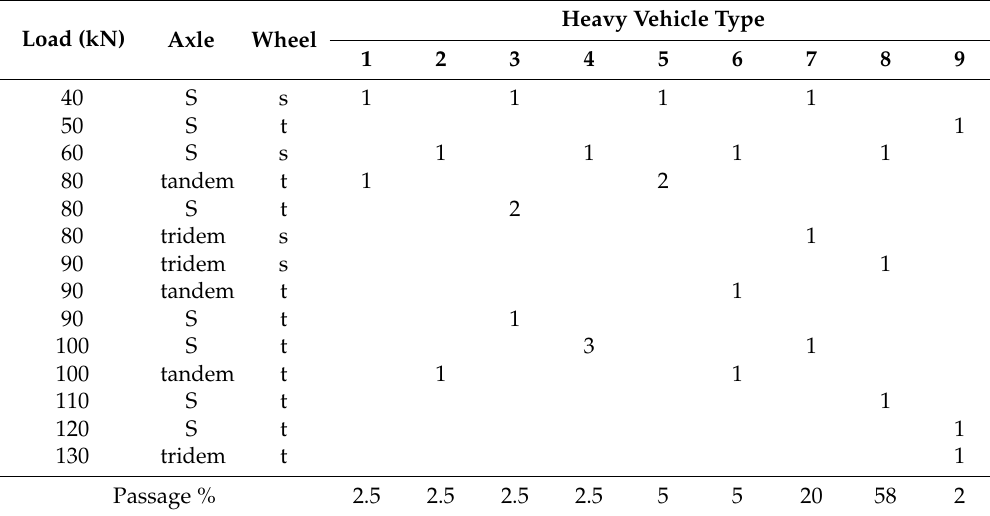
Table 3. Considered heavy